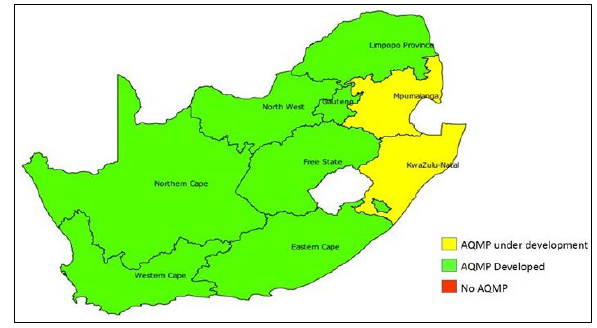
Figure 2: Current development status of provincial Air Quality Management Development Plans in South